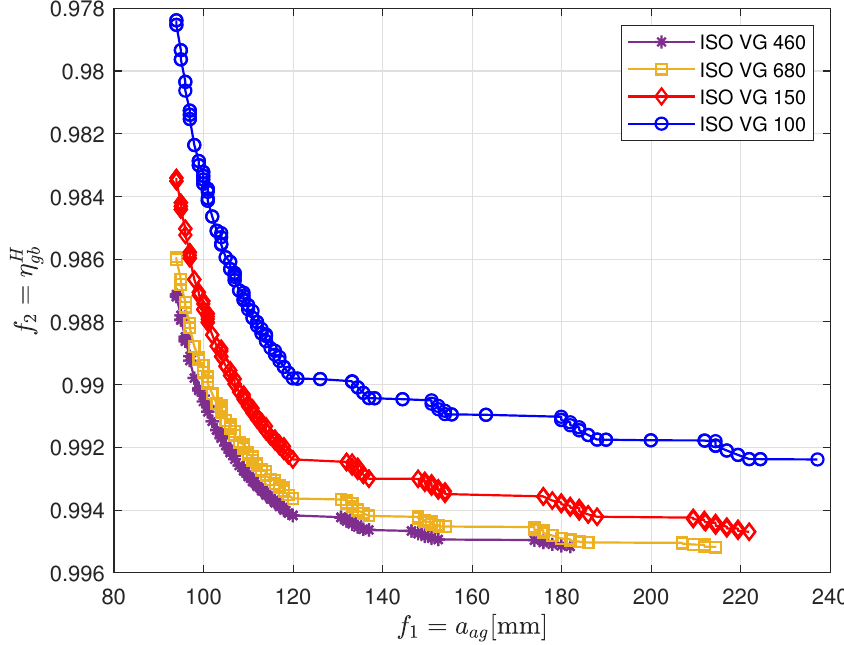
Figure 8. Pareto frontier for center distance and gearbox efficiency for different ISO grade